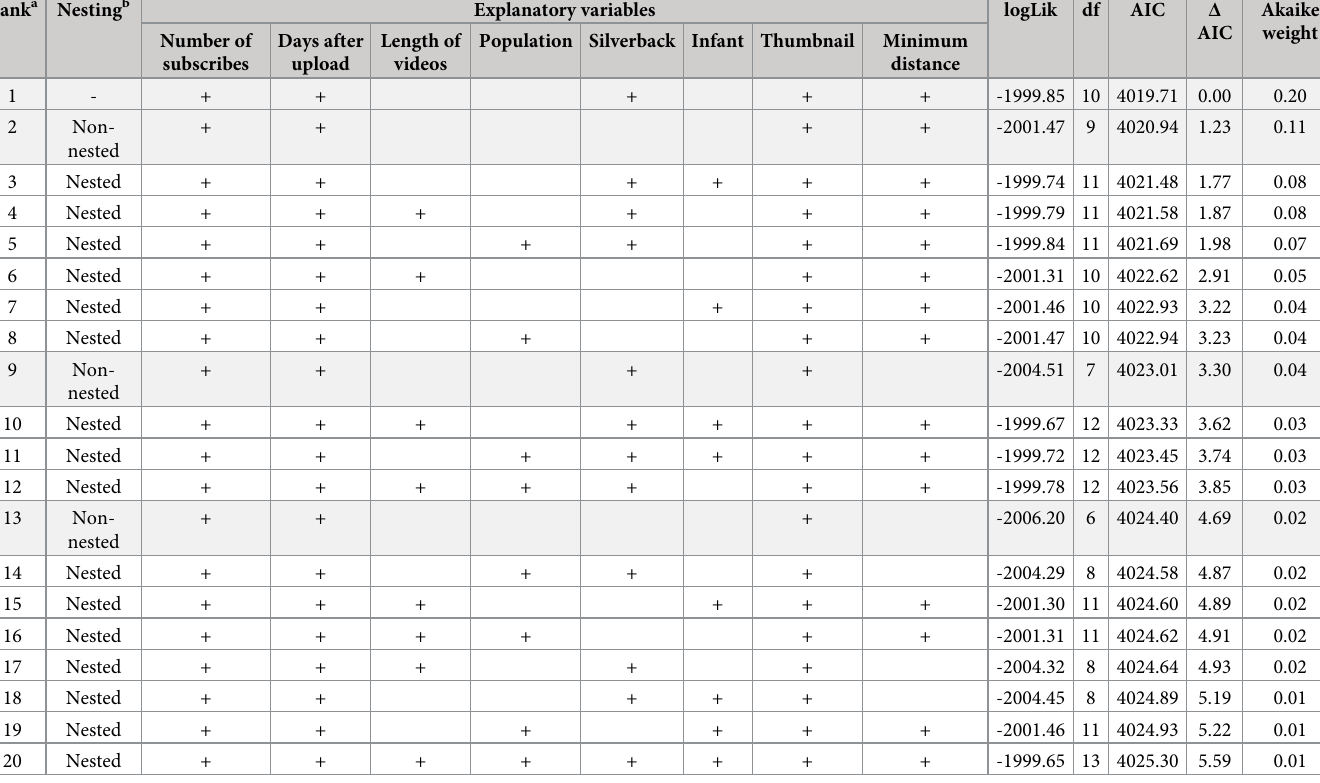
Table 1. Top-ranked candidate models exploring the factors that affect the number of views of YouTube videos related to mountain gorilla tourism (only the mod- els with Δ AIC values less than 6 are shown). (N = 206). Rank a Nesting